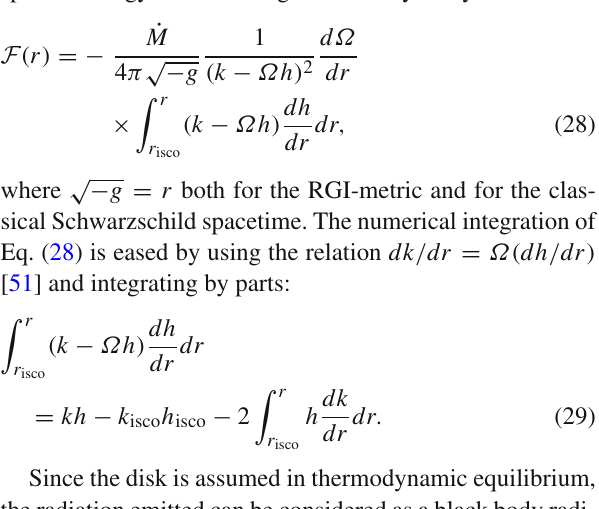
˙ M 1 / 4 ), respectively, for different values of profile of σ 1 / 4 T / ˜ ξ the dimensionless free parameter namely, for the critical ˜ ξ = 16 / 27, for ˜ ξ = 0 . 3 and for the classical solution value c ˜ ξ = ˜ ξ 0. From Fig. 6 we see that with the increase of